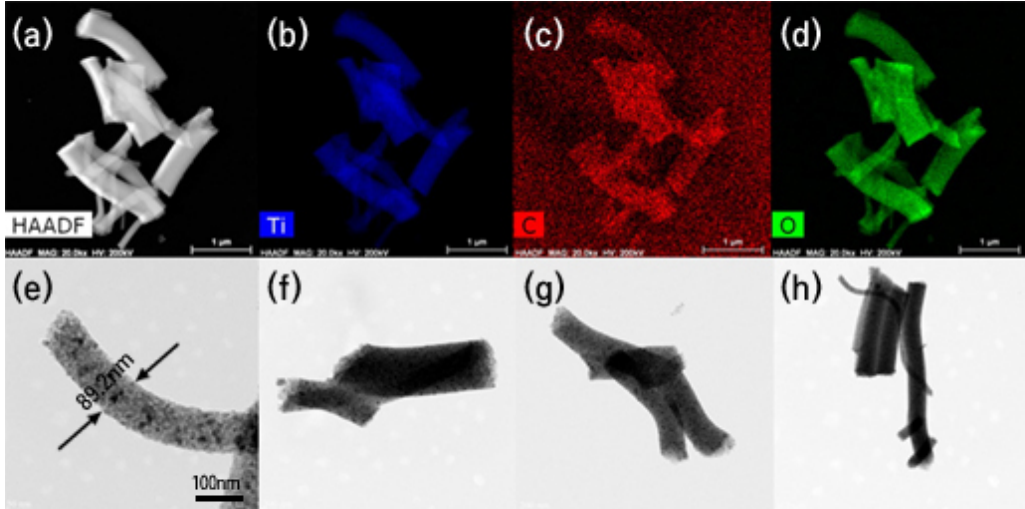
Figure 4. Typical high resolution TEM (HRTEM) images of the S4 (550) ( a , e ) and elemental mapping patterns of titanium ( b , f ), carbon ( c , g ) and oxygen ( d , h ).